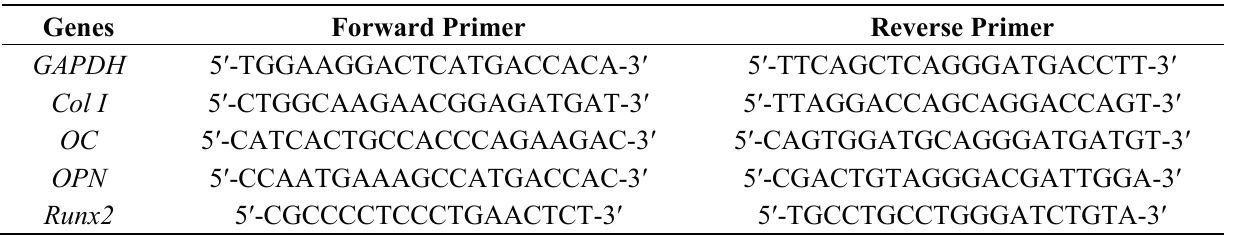
Table 1. Sequences of primers used for real-time